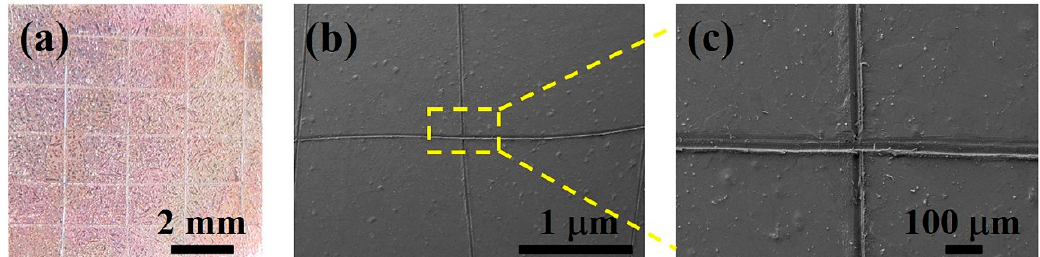
Figure 9. Surface morphology after adhesion test of the 140 °C-coated sample and corresponding partial enlarged image.